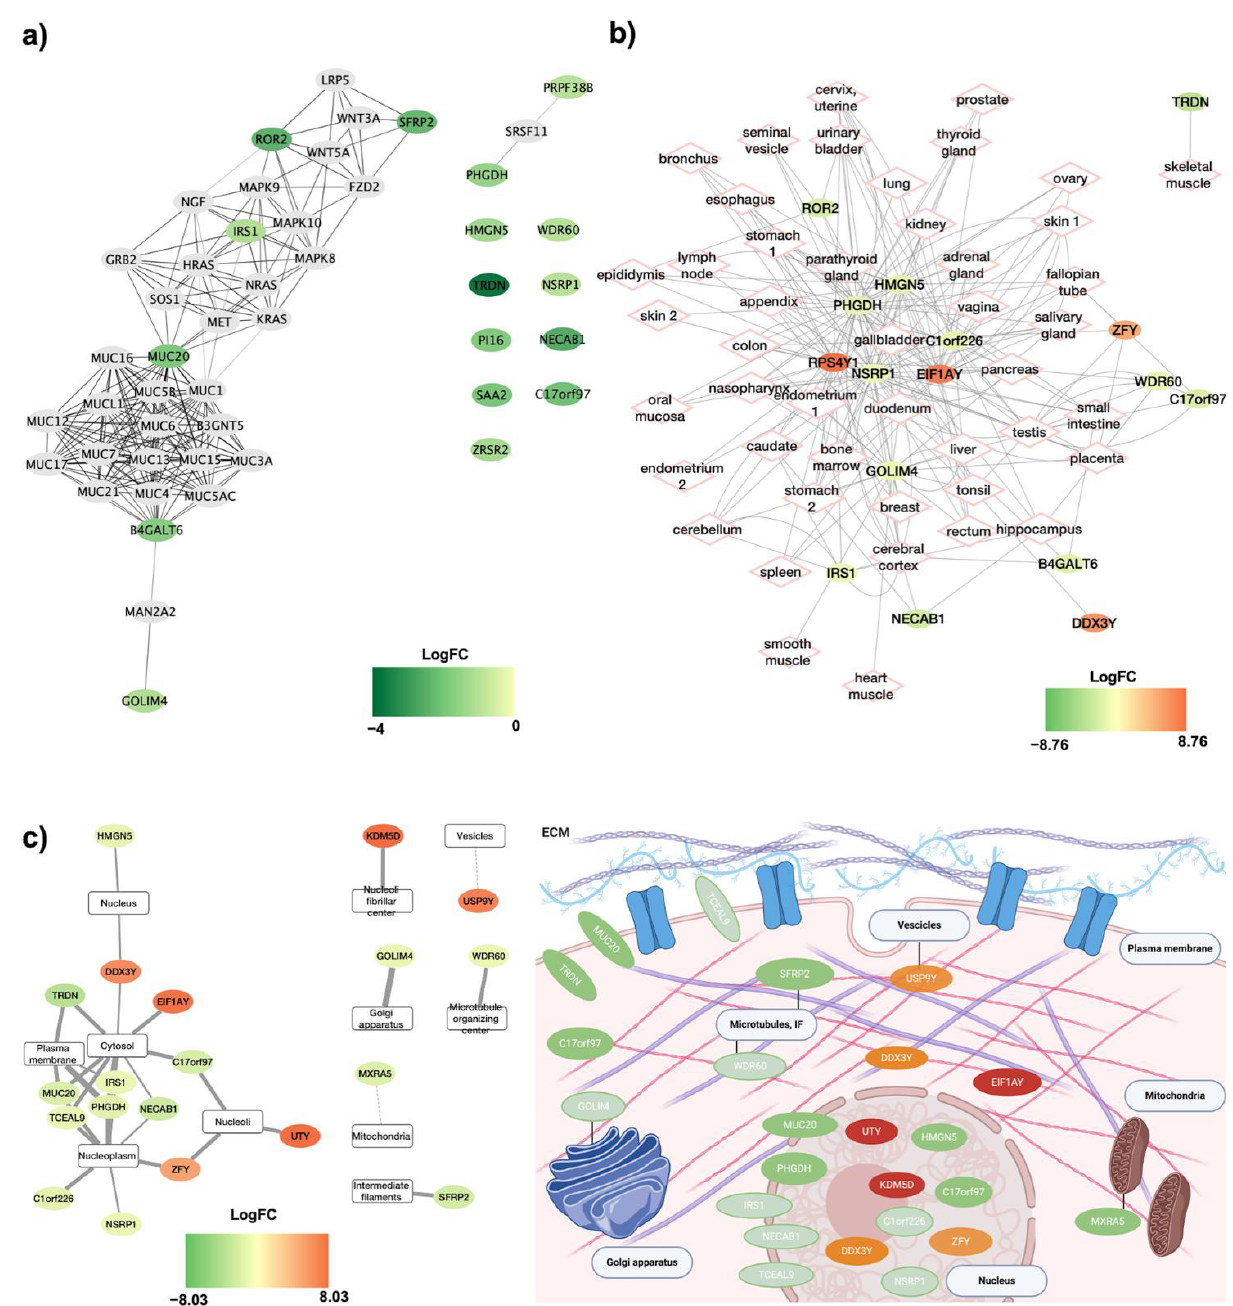
Figure 4. Characterization of DE RNAs interaction, tissue expression, and subcellular localization: ( a ) STRING protein network interaction as obtained through the NDEx plugin of Cytoscape. The DE RNAs are color-filled, and the color indicates the respective log 2 FC. Grey ellipses are the interacting proteins. ( b ) Tissue expression of DE RNAs as obtained through the NDEx plugin of Cytoscape. The DE RNAs are color-filled, and the color indicates the respective log 2 FC. ( c ) Subcellular localization of DE RNAs as obtained through the NDEx plugin of Cytoscape. The DE RNAs are color-filled, and the color indicates the respective log 2 FC. The DE RNAs are also localized using a graphical representation, made with Biorender.com.